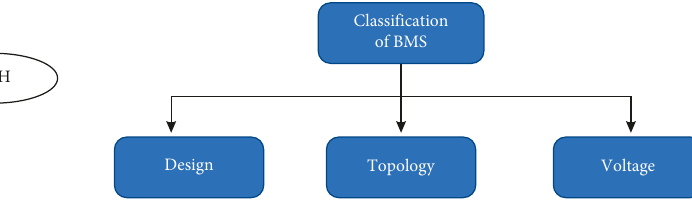
Figure 8: Classification of BMS.